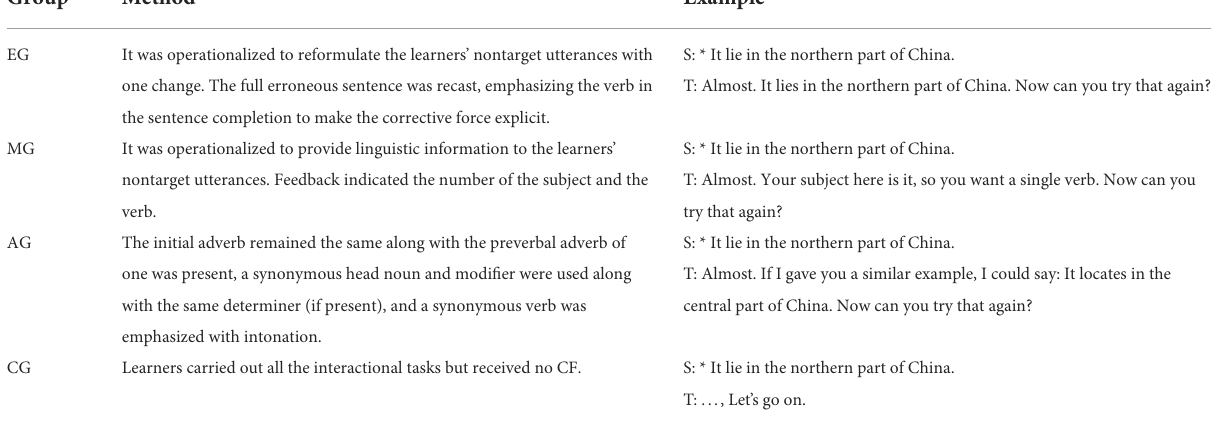
TABLE 2 Treatment conditions in interactional activities. Group Method